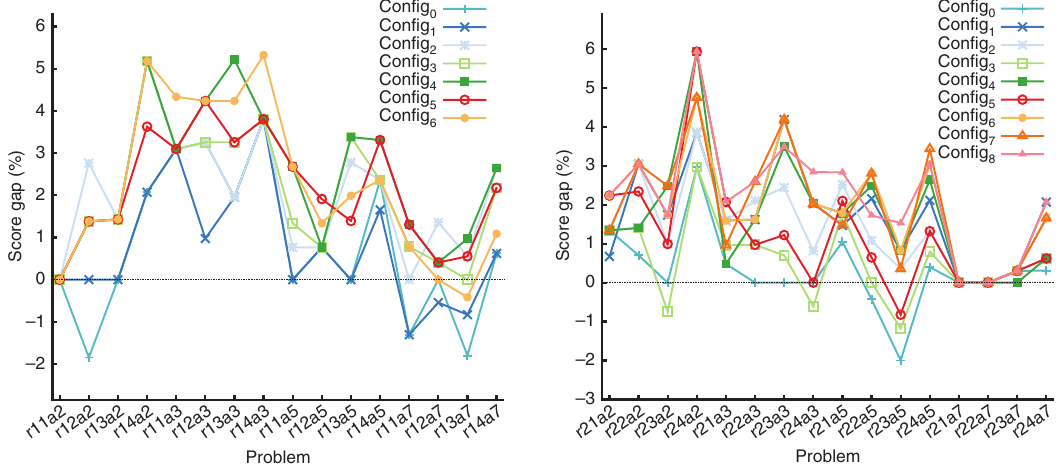
Figure 3: Enhanced ILS vs. ILS (Tuned as in §5.2) Score Gap Sensitivity to Free Parameters Setting (Config), with the Median Runs of Enhanced